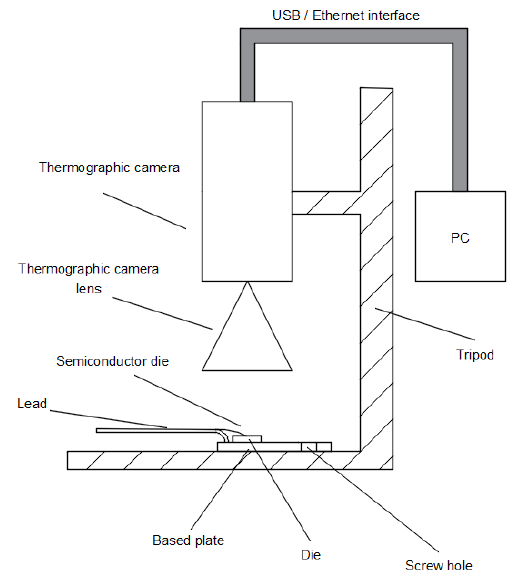
Figure 14. The use of thermal imaging cameras to measure the die temperature of a semiconductor